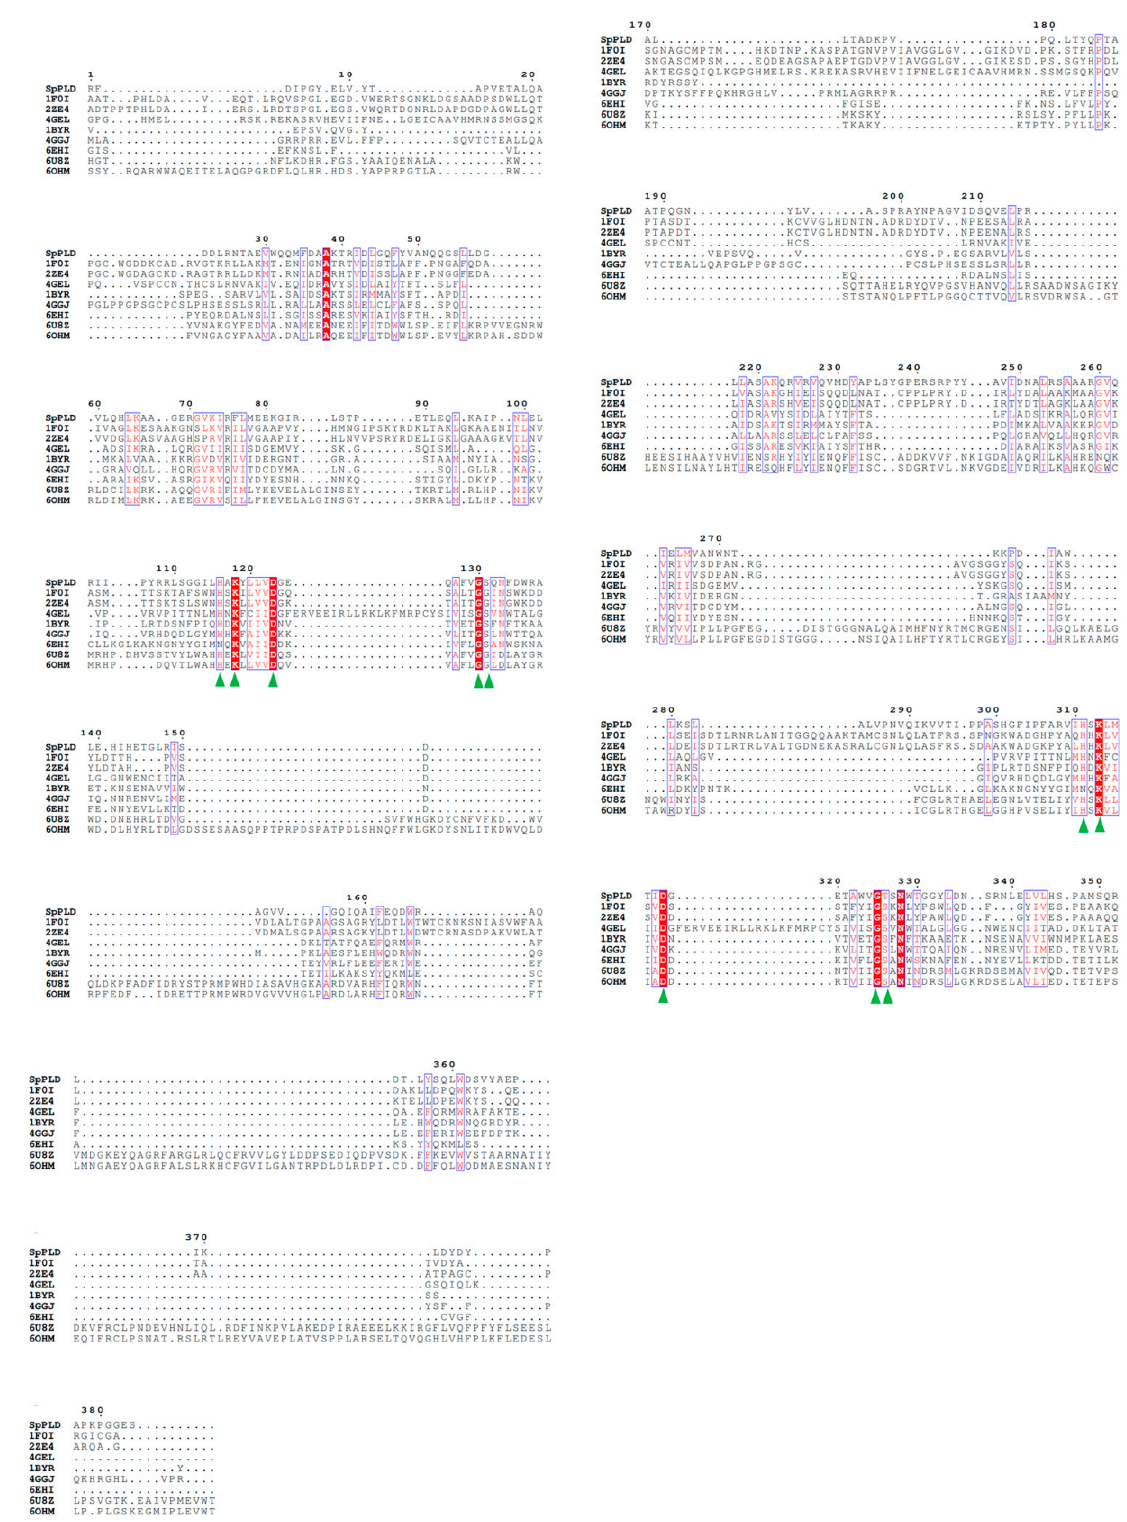
Figure 1. Structure-based amino acid sequence alignment of the mature SpPLD with several other PLDs in the PLDc 2 family. Residues in the conserved HKD motif of the PLD superfamily were indicated with green triangles. For the NucT from Helicobacter pylori (PDB ID: 6EHI), two histidines in the HKD motifs were mutanted to glutamine to obtain enzyme structure in the inactive